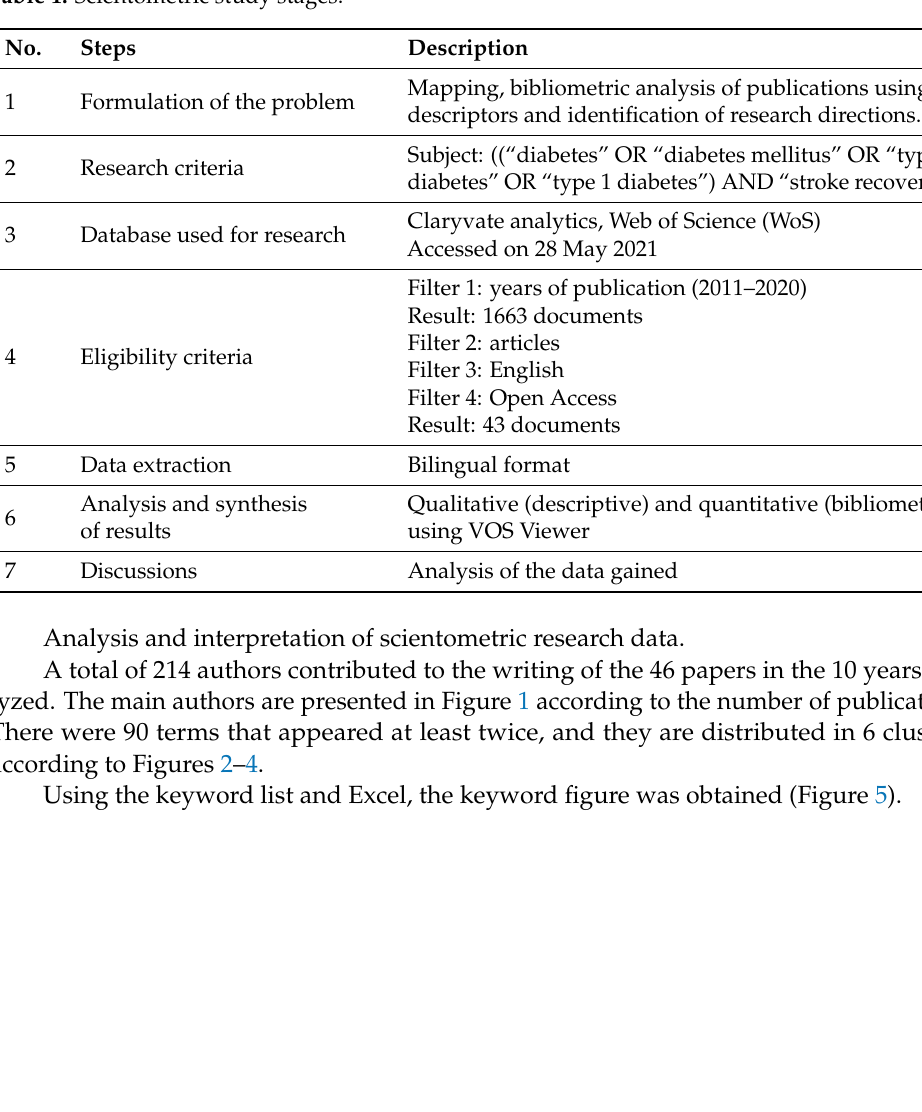
Table 1. Scientometric study